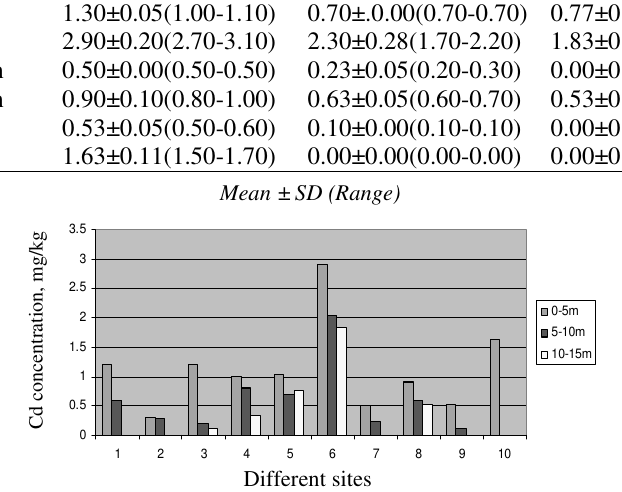
Figure 4. Cd (mg/kg) in roadside vegetable